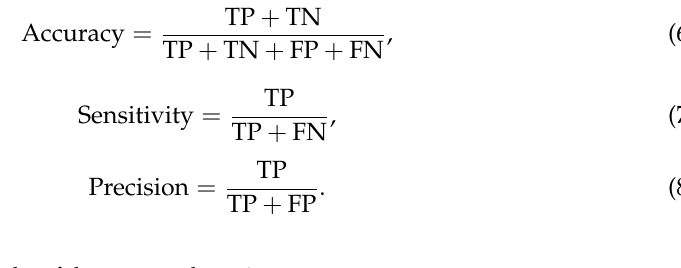
Table 1. The quantitative results of the proposed sensing system.